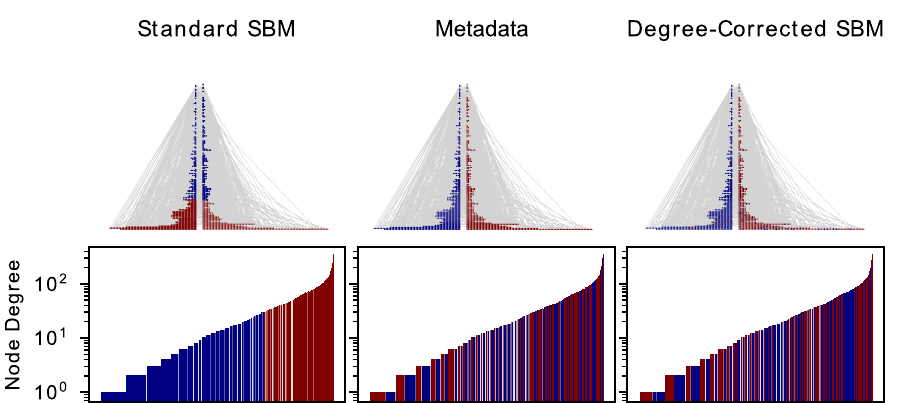
Fig 2. Visualization of a complex network with three partitions, the result of standard SBM and degree-corrected SBM as well as the metadata. The networks are drawn by ordering the nodes by degree with the highest at the top and splitting the nodes according to the known metadata into two sets. The color of each node represents the membership to one of the two groups given by the partition of the respective column. Below the network graphics, the degree distribution is colored according to its partitions. Each node represents a bar with the height of its degree and the color of its group.